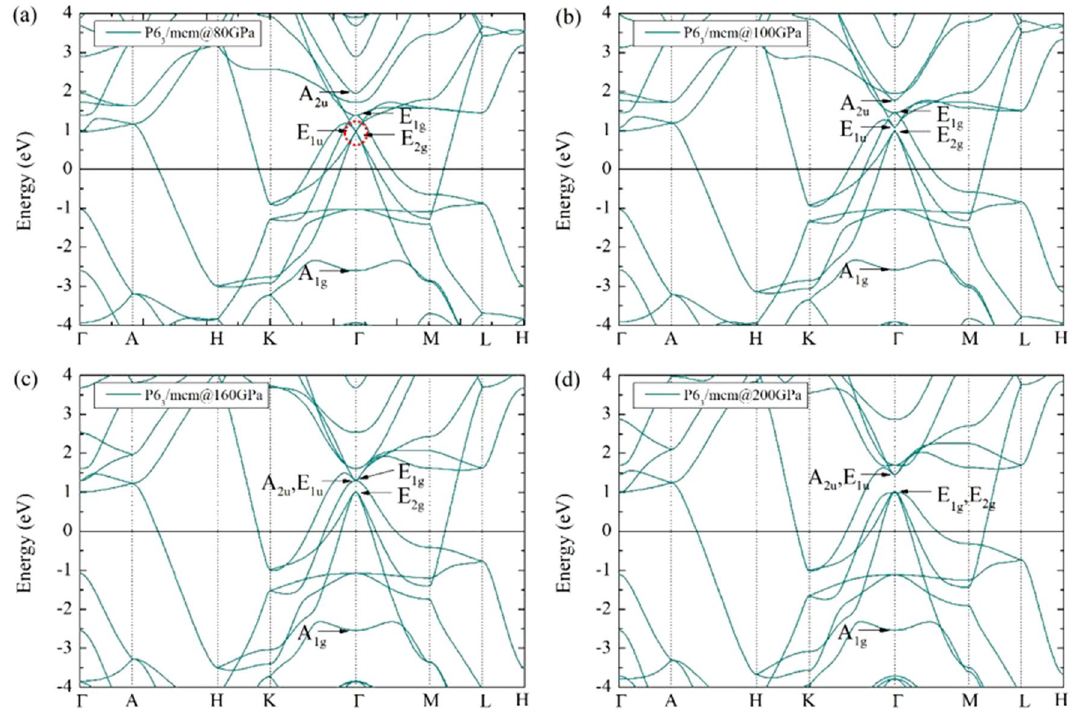
Figure 5. The band structure of Li 5 MoH 11 (a) P6 3 /mcm at 80 GPa, (b) P6 3 /mcm at 100 GPa, (c) P6 3 /mcm at 160 GPa, and (d) P6 3 /mcm at 200 GPa,